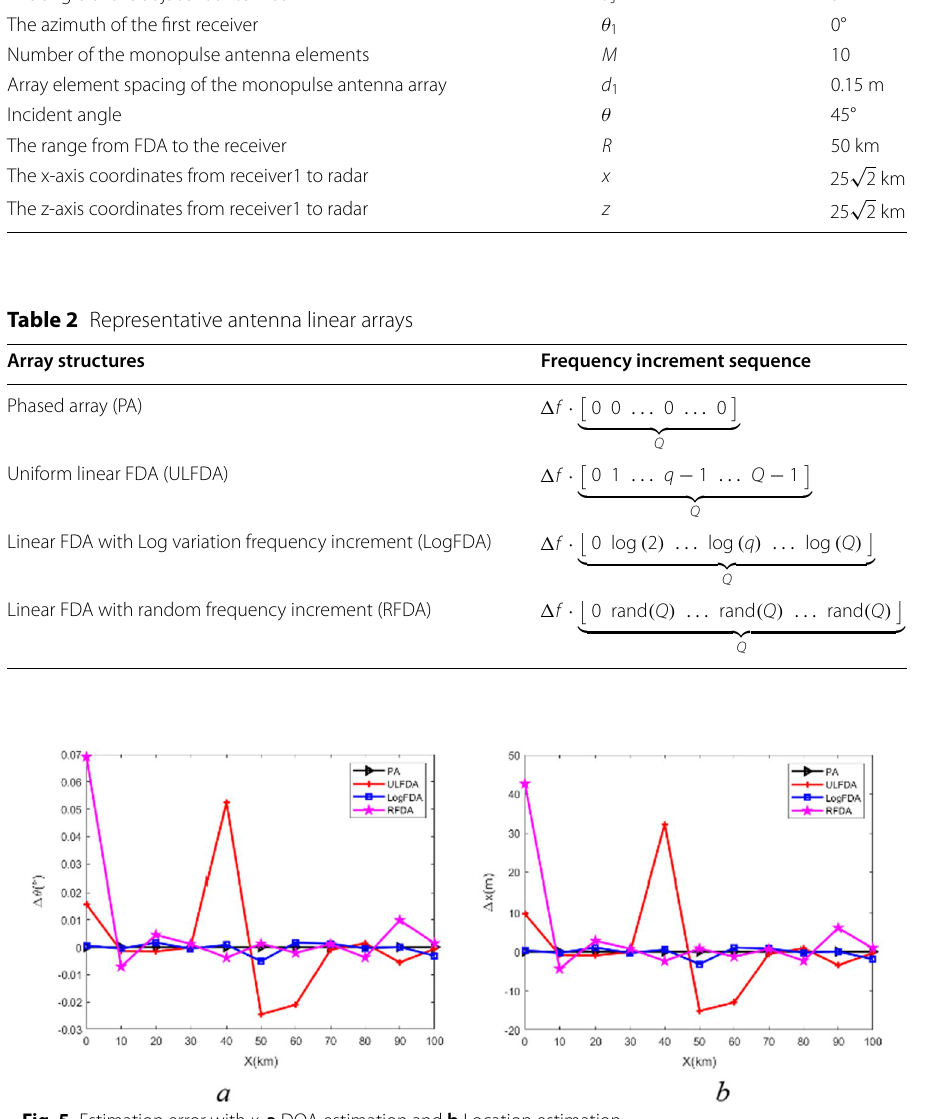
Fig. 5 Estimation error with x . a DOA estimation and b Location